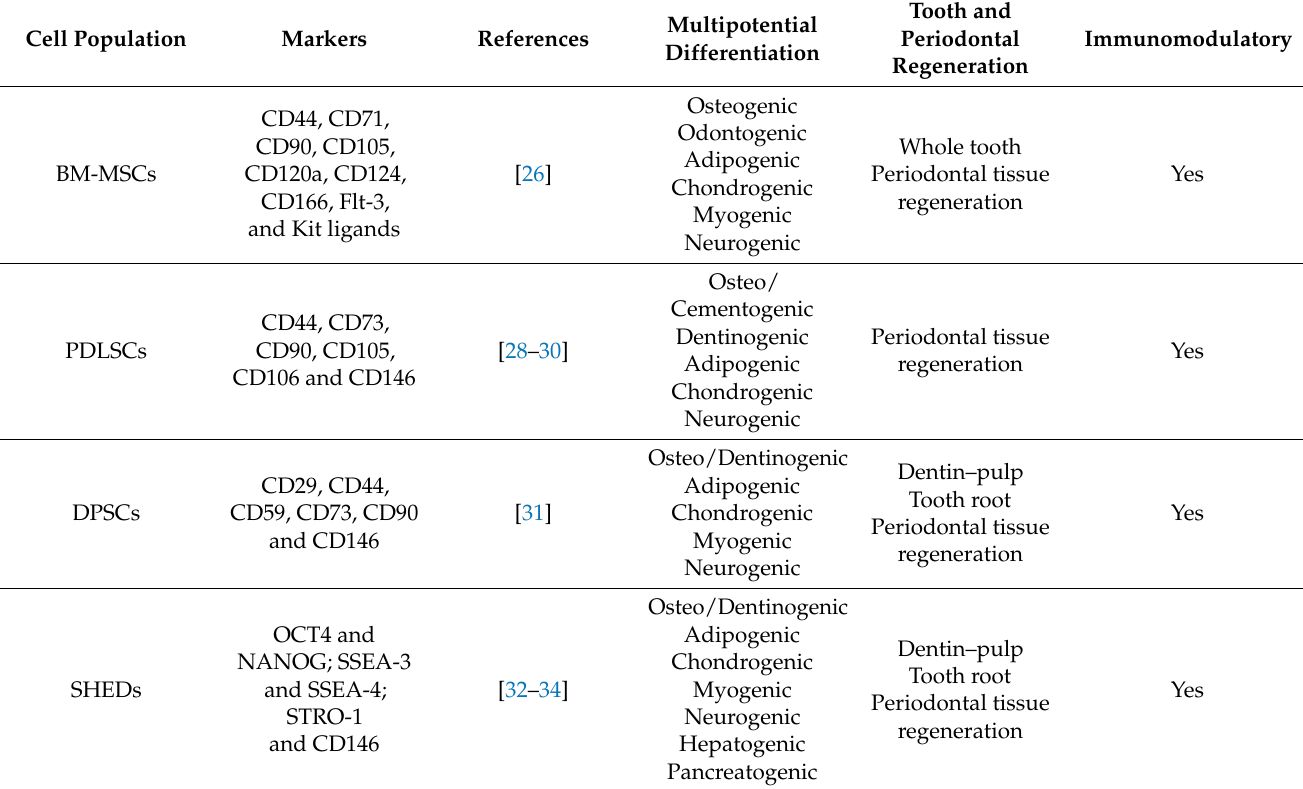
Figure 1. Isolation and differentiation of mesenchymal stem cells from bone marrow. Table 1. Specific markers expressed from the mesenchymal stem cells, their multipotential differentiation, their application in tooth and periodontal regeneration and their immunomodulatory role.